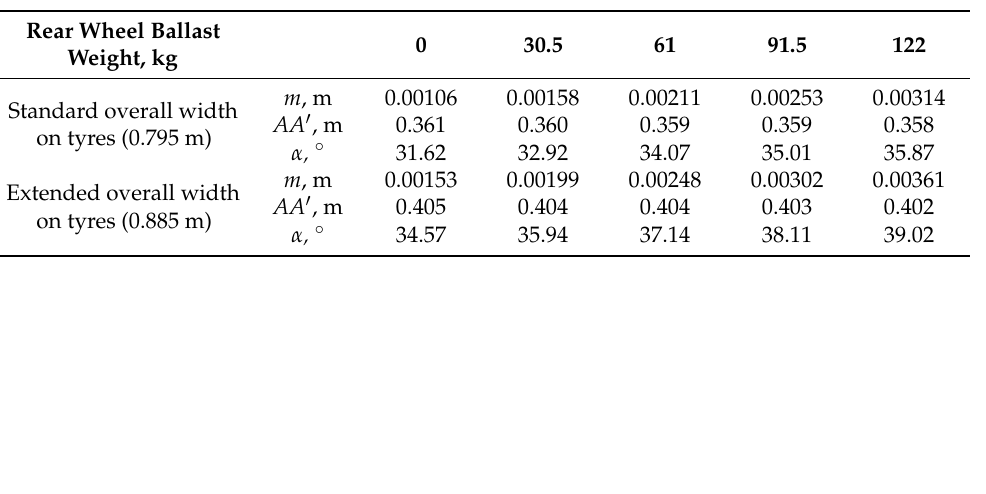
Table 5. Calculated data considering the tyre shift (lateral tyre deformation).